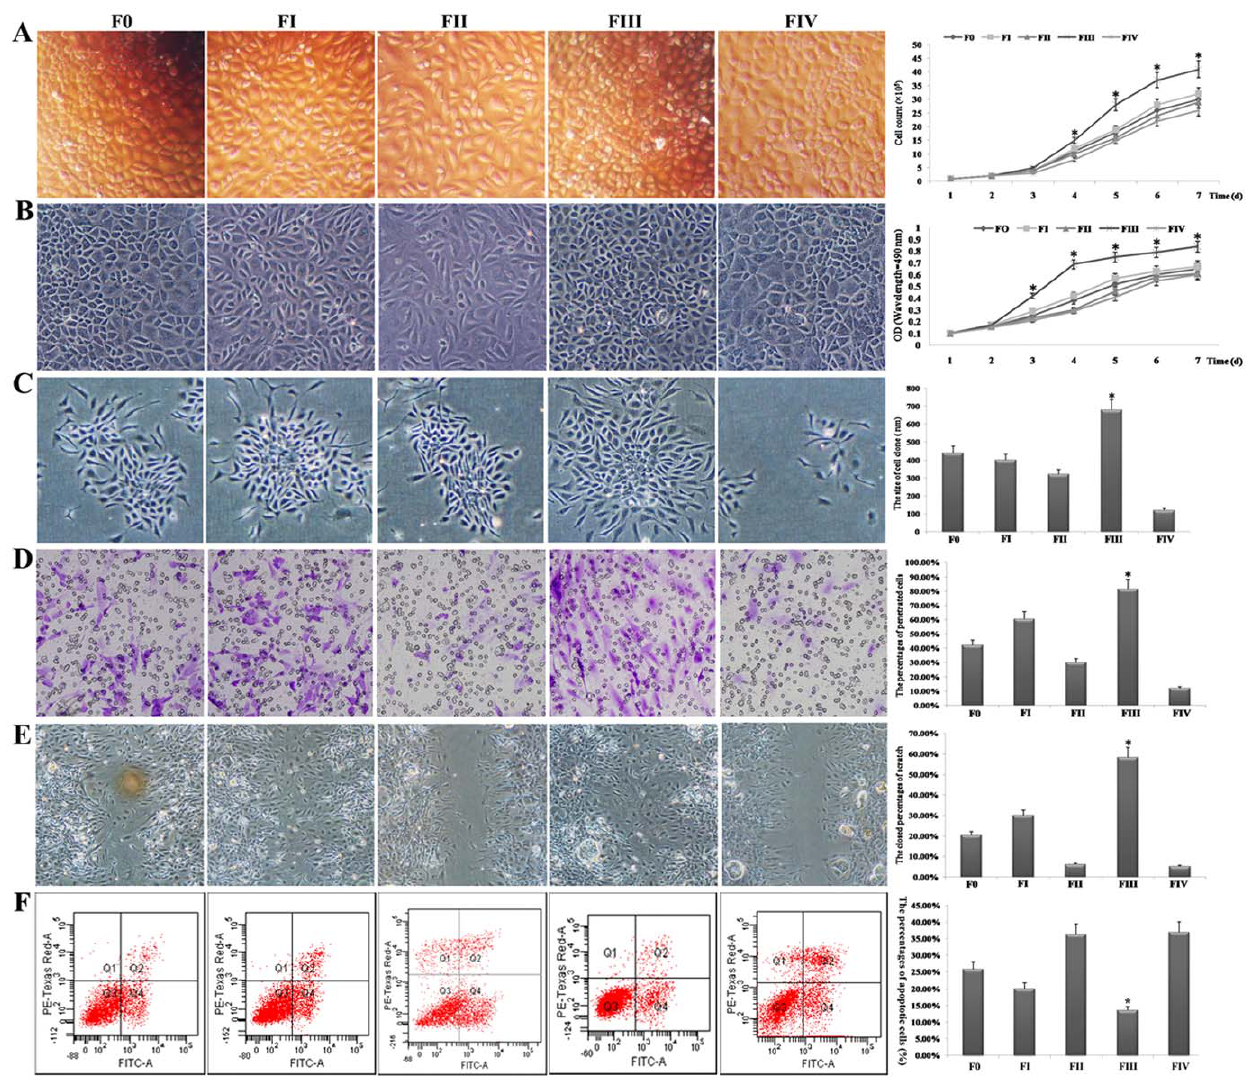
Figure 5. Proliferative and invasive capacities of cells from each fraction. (A) Left panel: light images of cells from each fraction after 7 d culture; right panel: column chart of cell counts during the cell culture period. (B) Left panel: gray images of cells from each fraction after 7 d culture; right panel: results of MTT assays during the cell culture period presented in a column chart. (C) Left panel: gray images of cell colonies generated by cells from each fraction; right panel: average diameters of cell colonies summarized in a column chart. (D) Left panel: light images of penetrating cells from different fractions in transwell assays; right panel: average percentages of cells that crossed the membrane are shown using a column chart. (E) Left panel: grayscale images of scratch assays showing the different abilities among cells from different fractions to close scratches via migration; right panel: average percentages of closed scratches are provided in a column chart. (F) Left panel: the apoptotic analysis for cells from each fraction by FCM; right panel: the percentages of apoptotic cells are shown by a column chart. F0 represents unfractionated HTCs; FI-IV indicates fractions I–IV after separation. * refers to P , 0.01 compared with any other fraction. Original magnification: 200 6 (A–D), 100 6 (E).